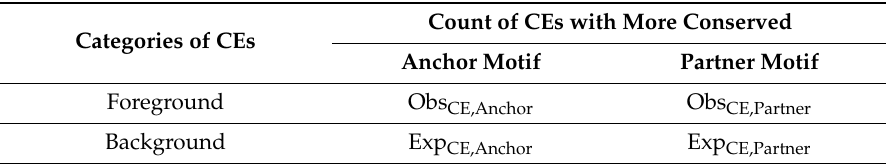
Table 2. 2 × 2 contingency tables for calculation of CE